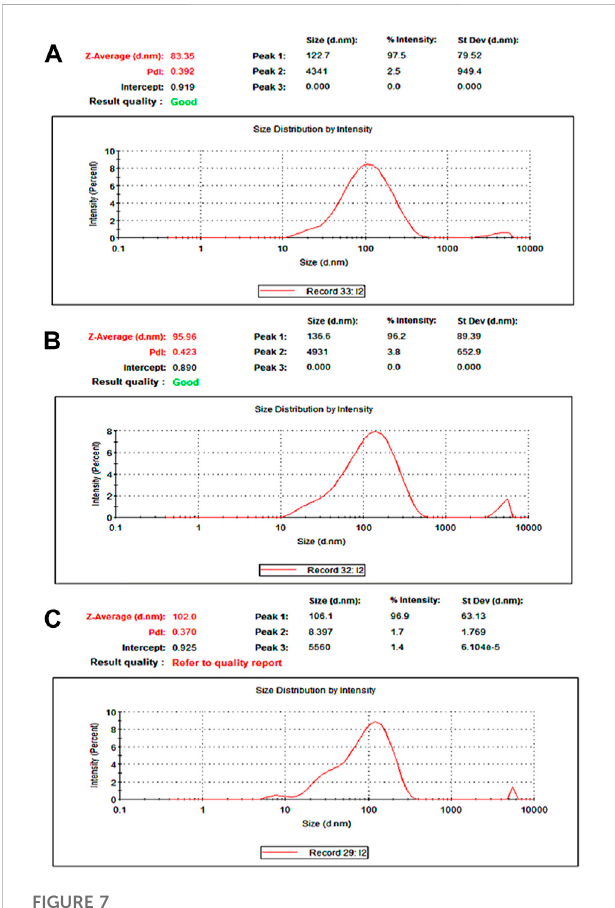
FIGURE 7 Particle size distribution measured using the laser particle size analyzer (A) S1; (B) S2; (C) S3.